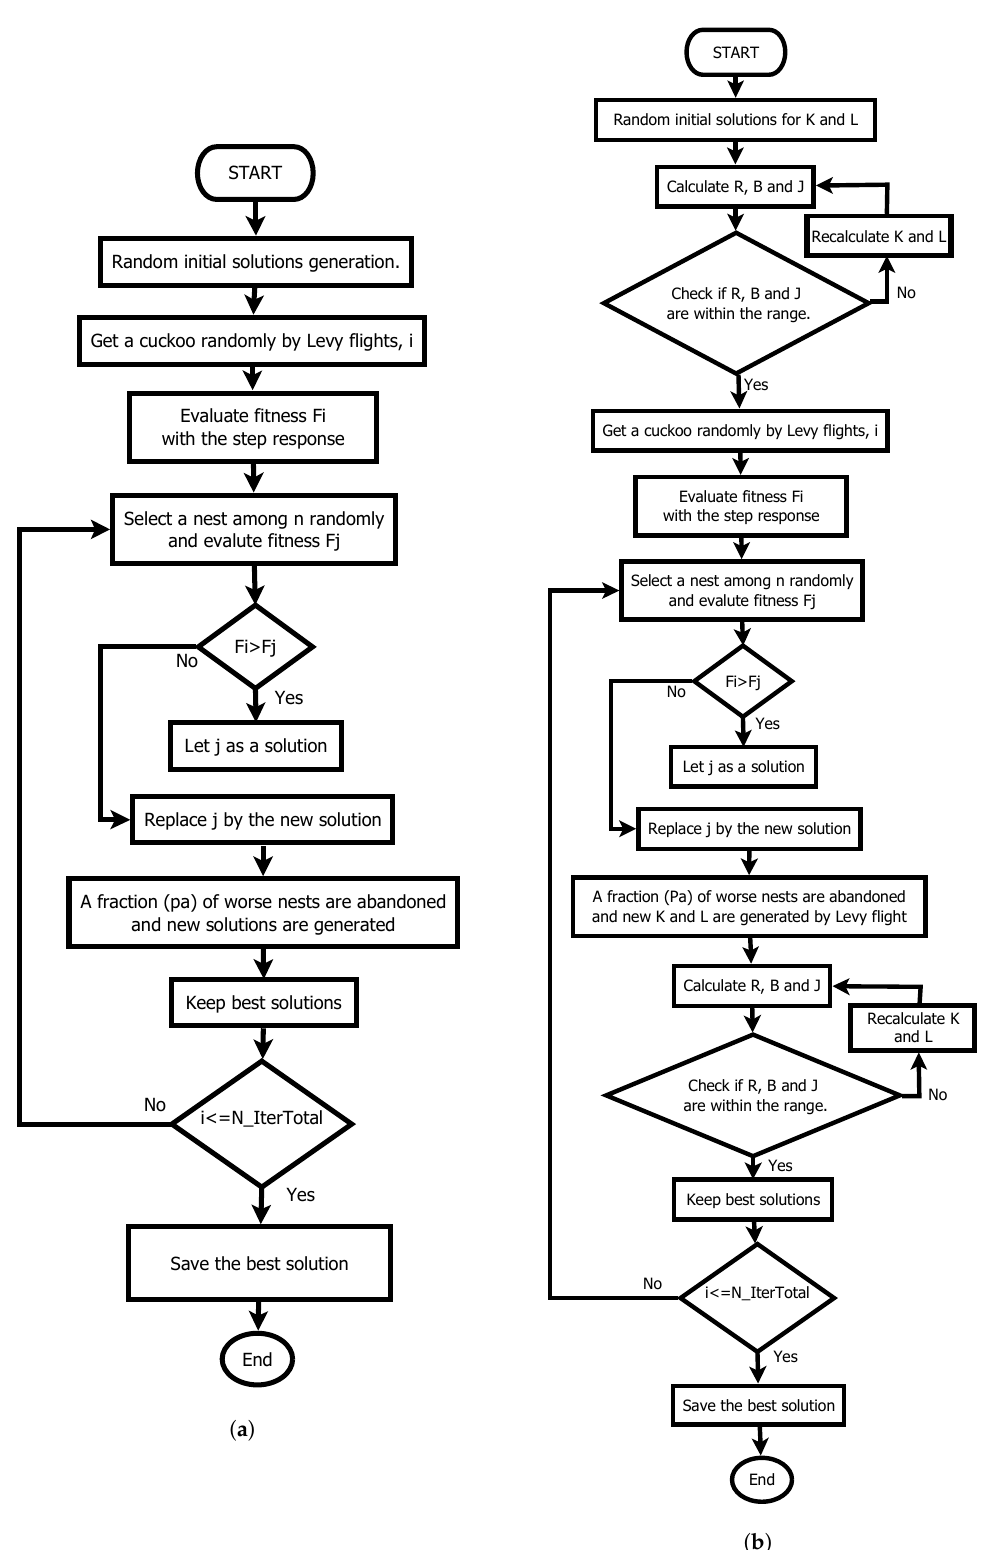
Figure 5. Cuckoo Search algorithm. ( a ) Original Cuckoo search; ( b ) Modified algorithm with dynamics